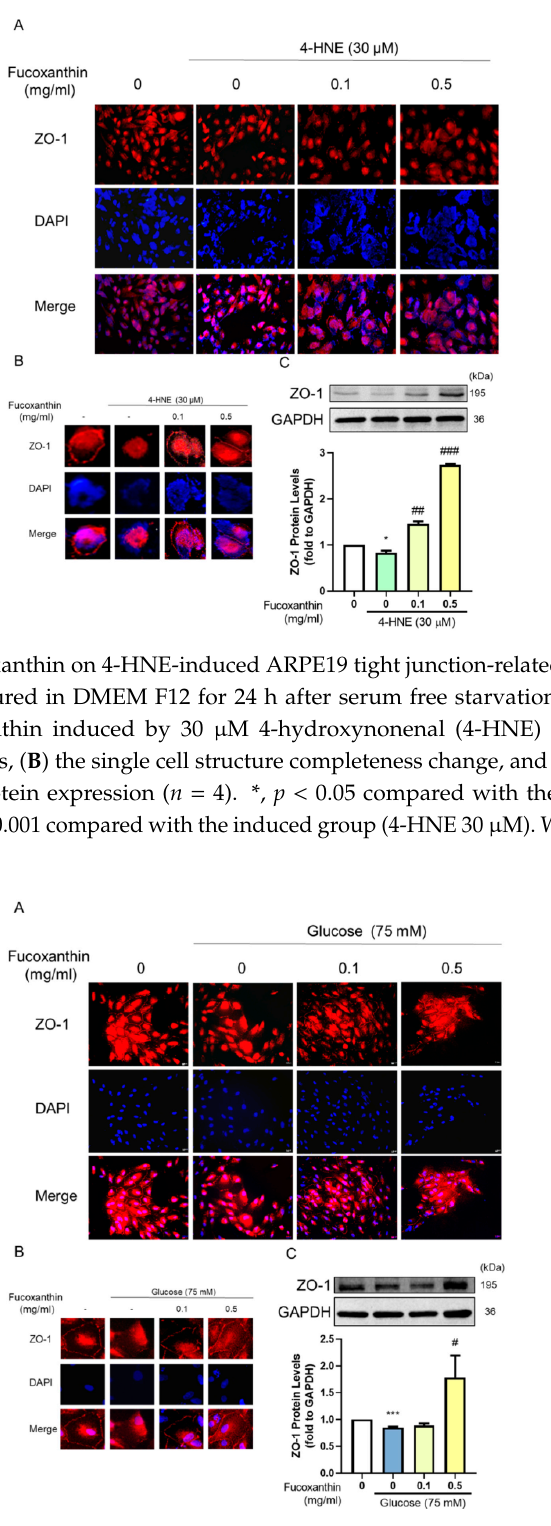
Figure 6. Effects of fucoxanthin on high glucose-induced ARPE19 tight junction-related protein expression. ARPE19 cells were cultured in DMEM F12 for 24 h after serum free starvation for 18 h. This was combined with fucoxanthin induced by 75 mM glucose for 72 h. We used ( A ) immunofluorescences, ( B ) the single cell structure completeness change, and ( C ) Western blotting to analyze the ZO-1 protein expression ( n = 4). ***, p < 0.001 compared with the non-treated group. #, p < 0.05 compared with the induced group (glucose 75 mM). We used a microscope at 40 ×